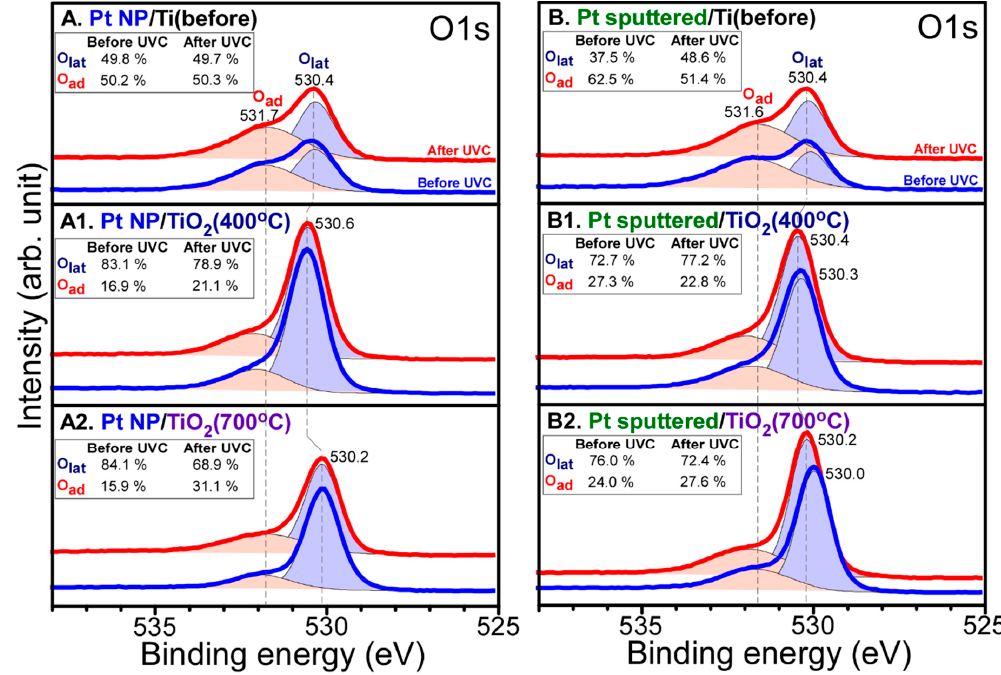
Figure 5. O 1s XPS of: ( A ) Pt NP/Ti; ( A1 ) Pt NP/Ti (400 °C); ( A2 ) Pt NP/Ti (700 °C); (B ) Pt-sp/Ti; ( B1 ) Pt-sp/Ti (400 °C); ( B2 ) Pt-sp/Ti (700 °C) samples before (blue) and after (red) CO 2 reduction. Inset tables show relative ratios of the deconvoluted peaks.